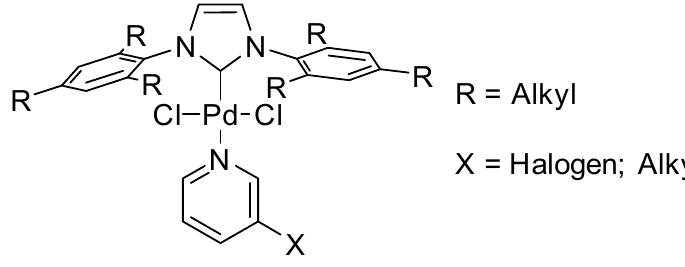
Scheme 1. Schematic representation of the Pd ‐ PEPPSI conceptual complex.